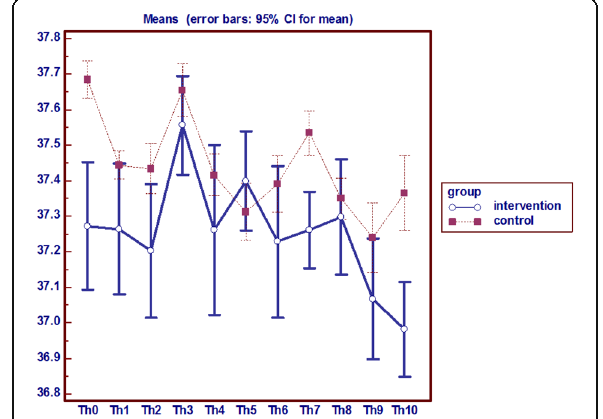
Fig. 2 Analysis of variance with repeated measures on the hip (trochanter) temperature